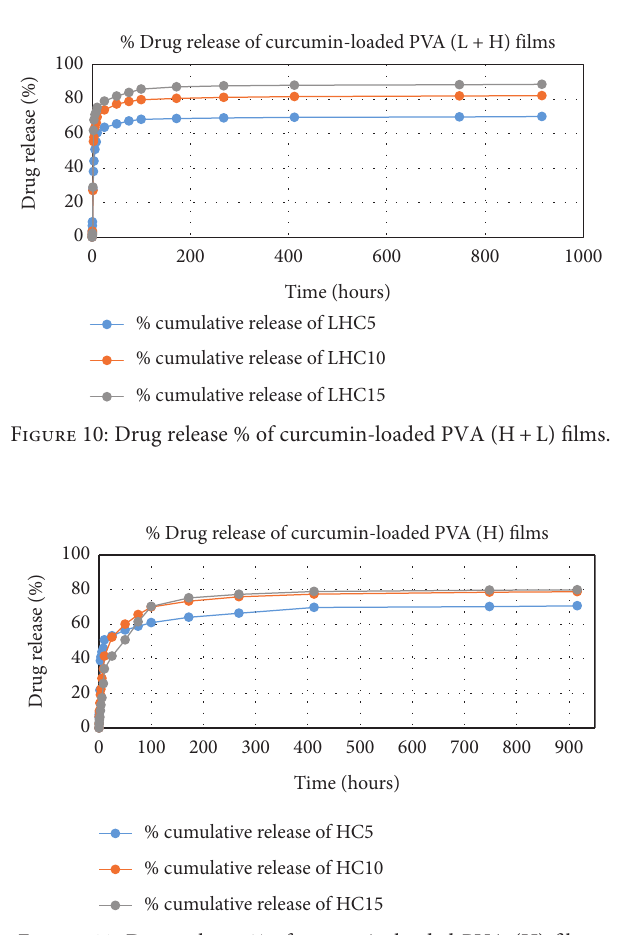
Figure 11: Drug release % of curcumin-loaded PVA (H) films.